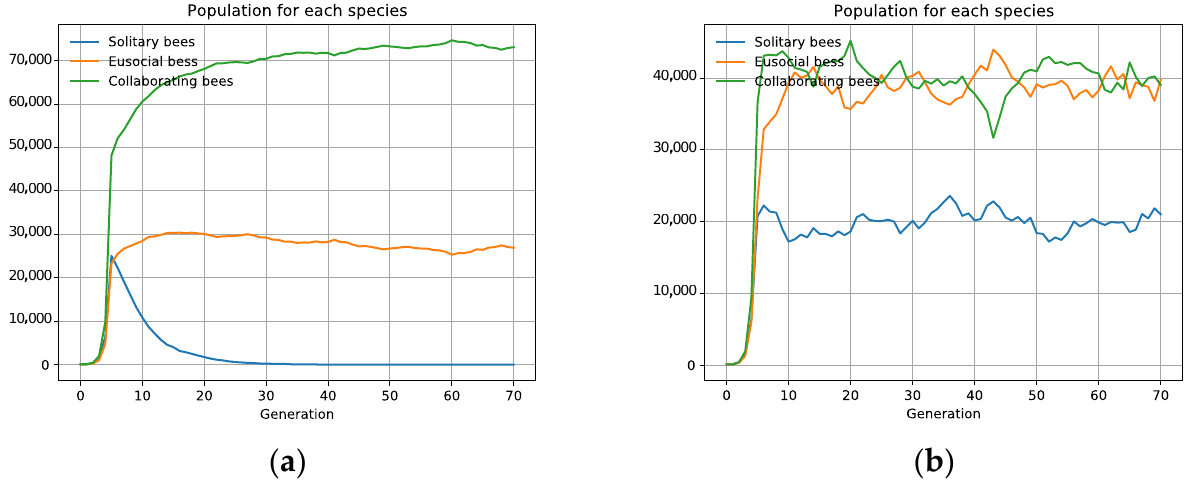
Figure 5. If social bees have greater fitness, they prevail over solitary ones, but only in uniform distributions ( a ). In both charts, solitary bees are less efficient with a DirectOffpring of 4 instead of 5. However, they only survive if there is an aggregated distribution of 100r ( b ).